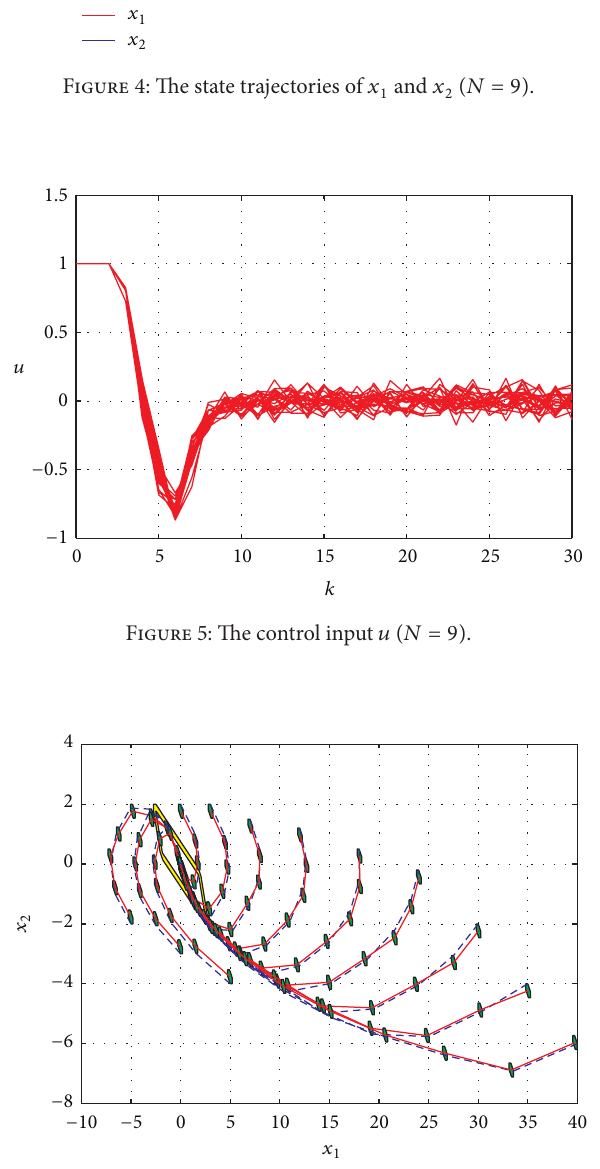
Figure 6: The phase trajectories starting from different initial points ( 𝑁 = 9 ).